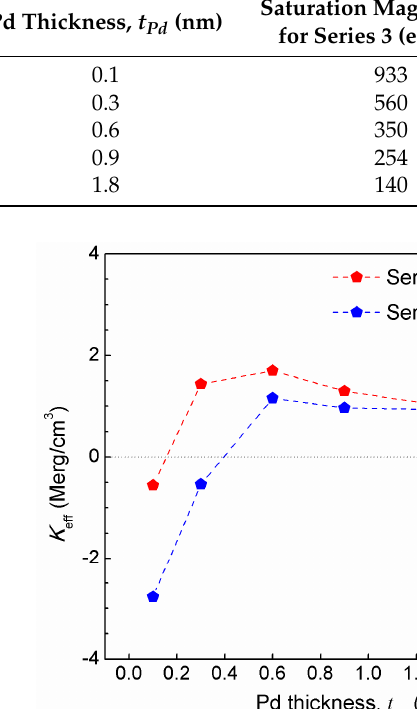
) ×10 ] and series 4 ) × 10 ] and series 4 Pd Pd ) ×10 ] samples Pd